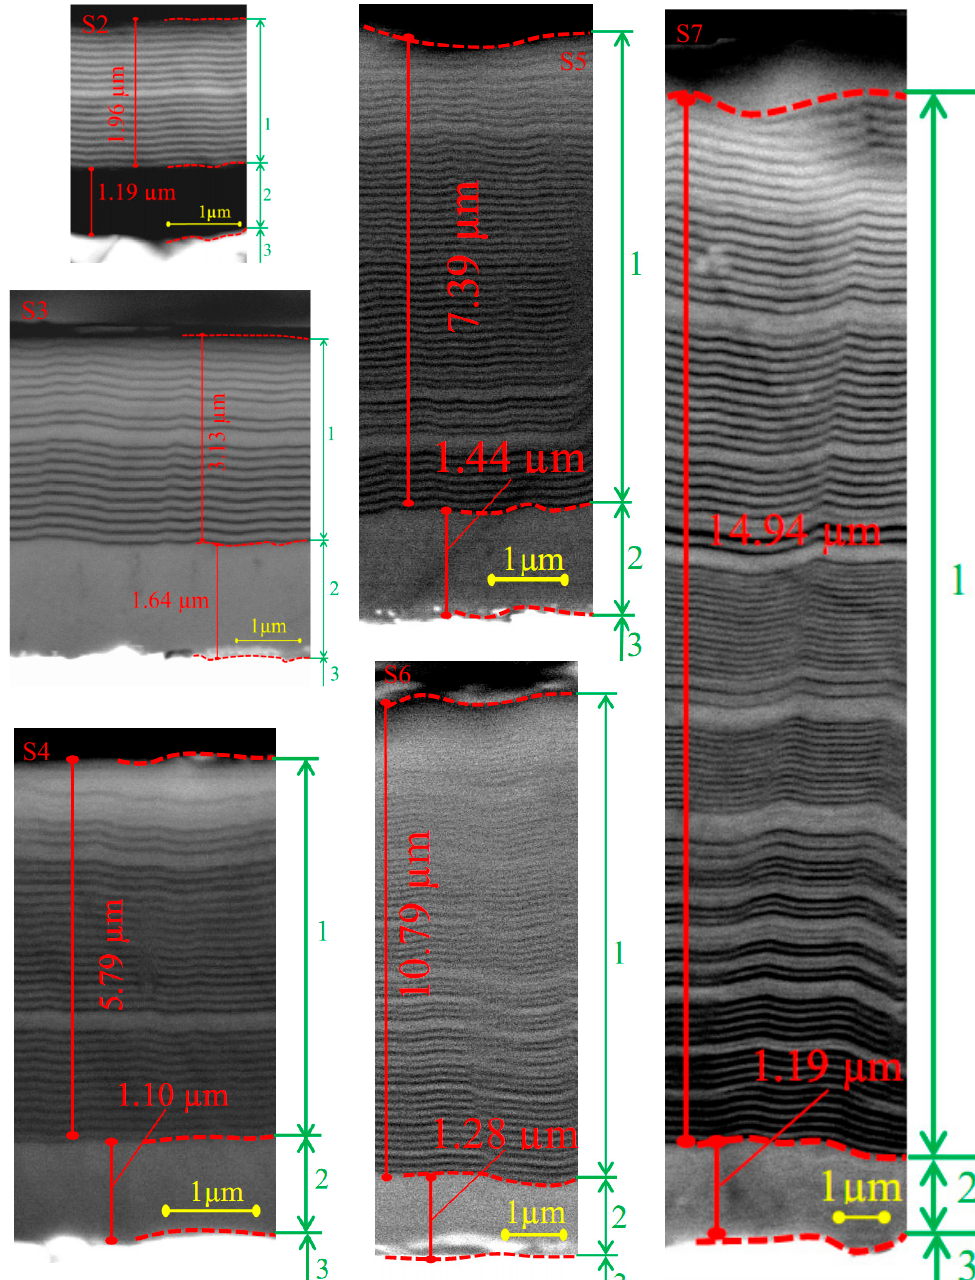
Figure 3. Thickness and elemental composition of coatings (S2–S7) under study.